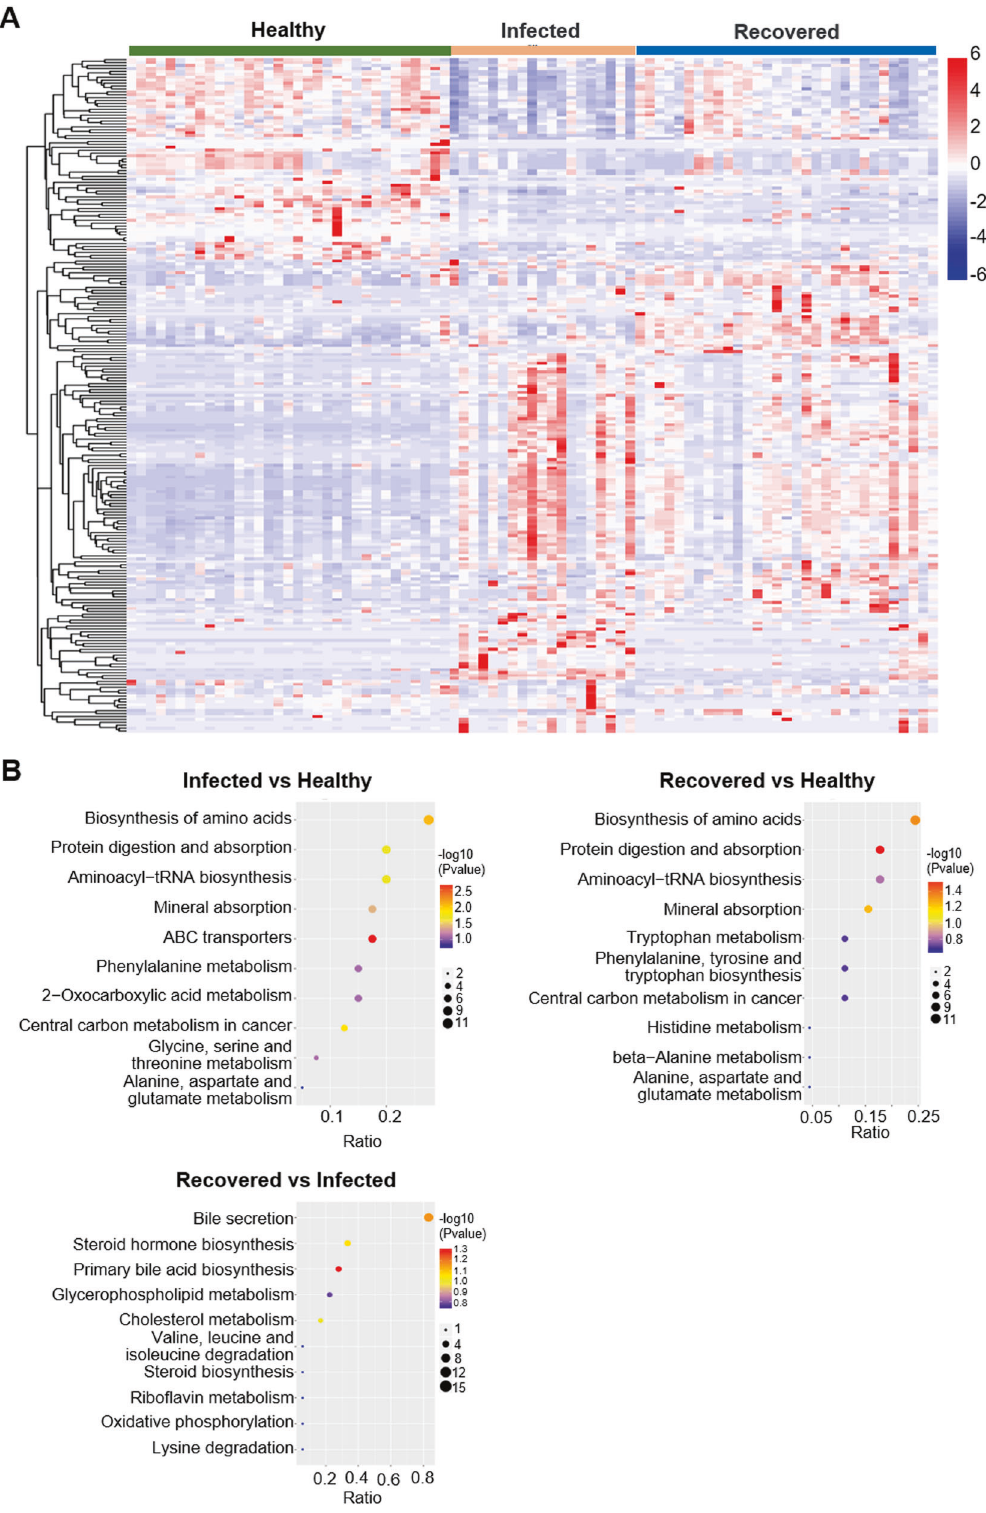
Fig. 2 Metabolomic pro fi ling of plasma samples obtained from patients with Omicron and healthy participants. A Heatmap visualization of signi fi cantly different altered metabolites (DEMs) in infected, recovered patients and healthy control participants. Metabolites in the heatmap showed a fold-change >1.5 and FDR < 0.05. The color bar represents the relative intensity of identi fi ed metabolites from − 6 to 6. B Bubble plots show the top 10 KEGG enrichment pathways. The ratio is the number of differential metabolites in the related metabolic pathway to the number of total metabolites identi fi ed in the pathway. The color of the dots represents − log 10 ( p value). The size of the dots represents the number of differential metabolites in the corresponding pathway.